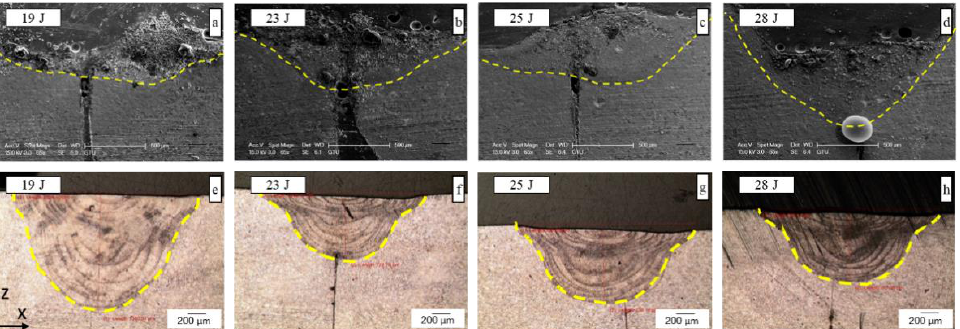
Figure 4. The relationship between the laser energy and penetration depth where focal distance d = − 6 mm, welding speed V = 5 mm/s, frequency f = 20 Hz, and pulse duration t = 5 ms in serum obtained by SEM ( a – d ) and in air obtained by an optical microscope ( e – h ).